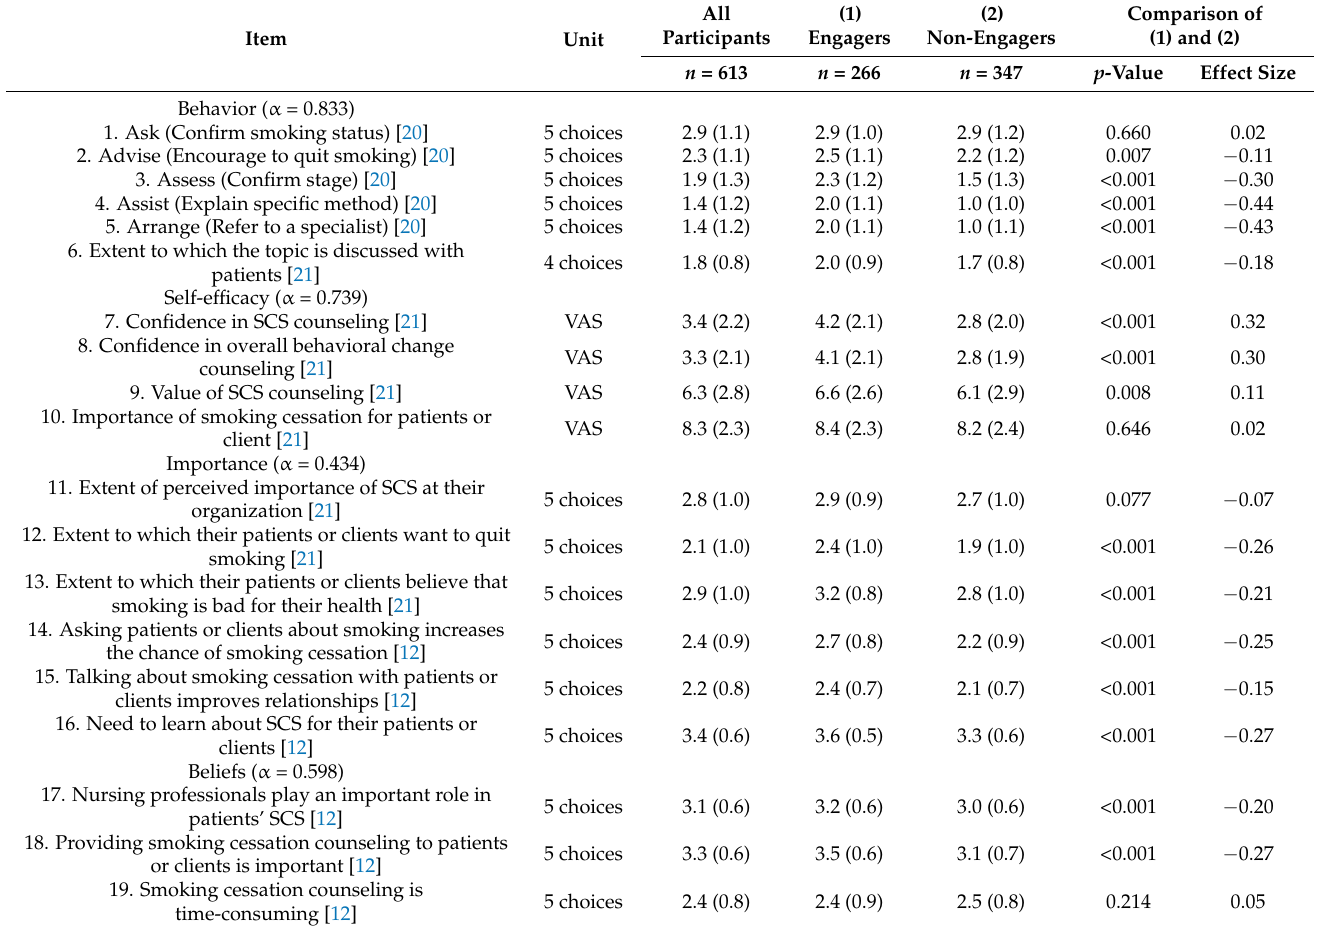
Table 2. SCS behaviors, perceived importance, attitude, and